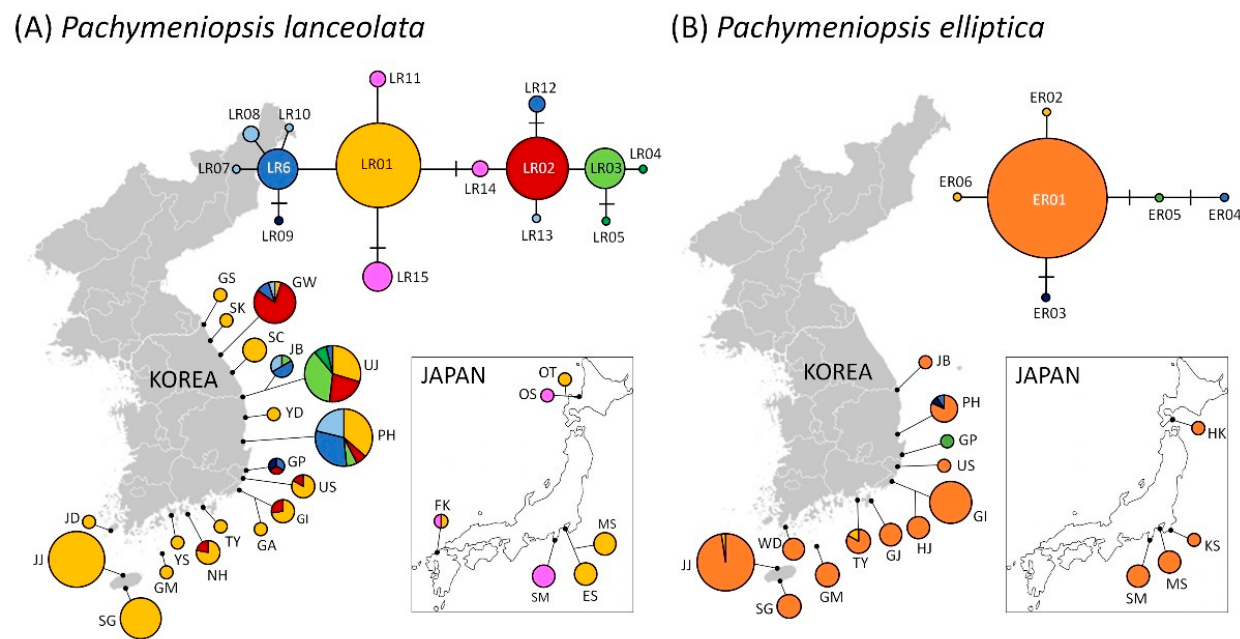
Figure 3. Geographic distribution of haplotypes and haplotype networks of Pachymeniopsis lanceolata ( A ) and P. elliptica ( B ) based on the plastid rbc L gene. On the map, each circle represents a location, and the proportions of the pie chart indicate the frequency of specimens for each haplotype. The pie chart color corresponds to the one used in the haplotype networks. In the network, each connecting line represents single mutational steps. The vertical bars represent the number of mutational steps between two haplotypes when >1.